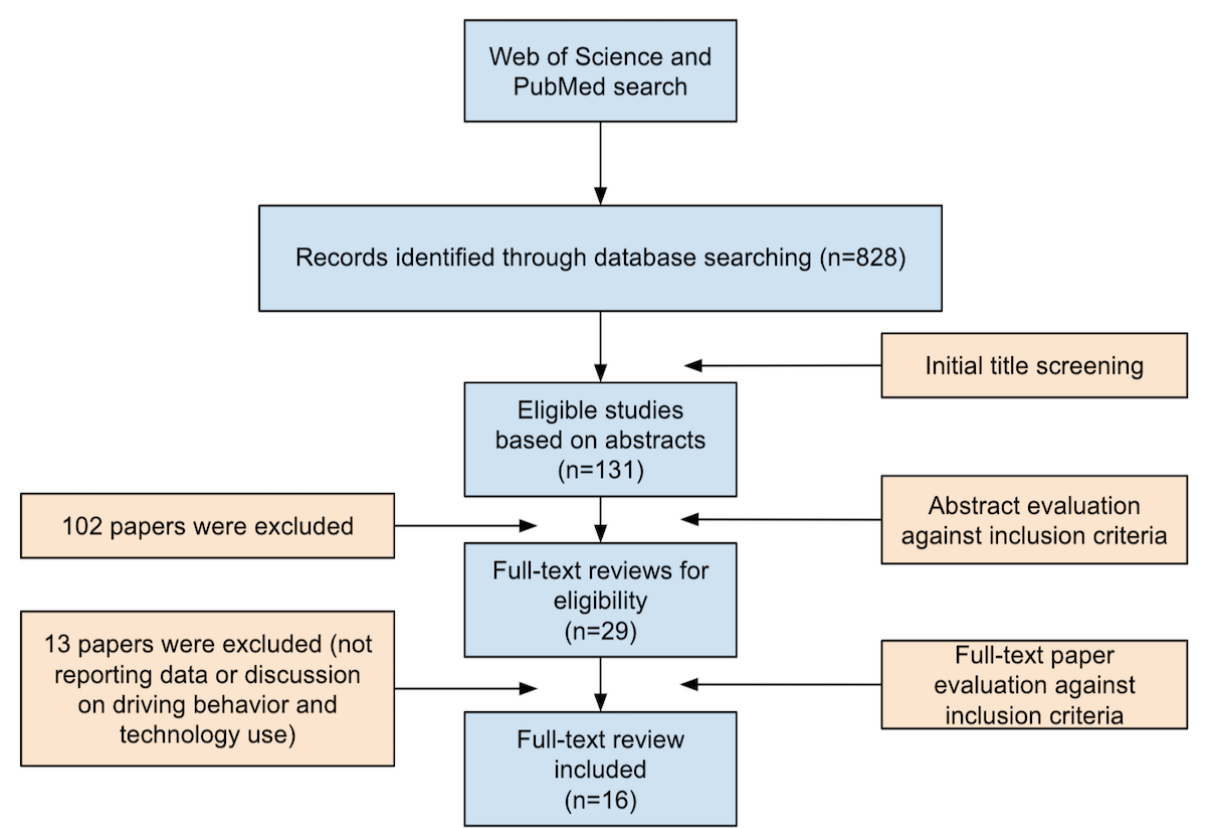
Figure 1. Review flow